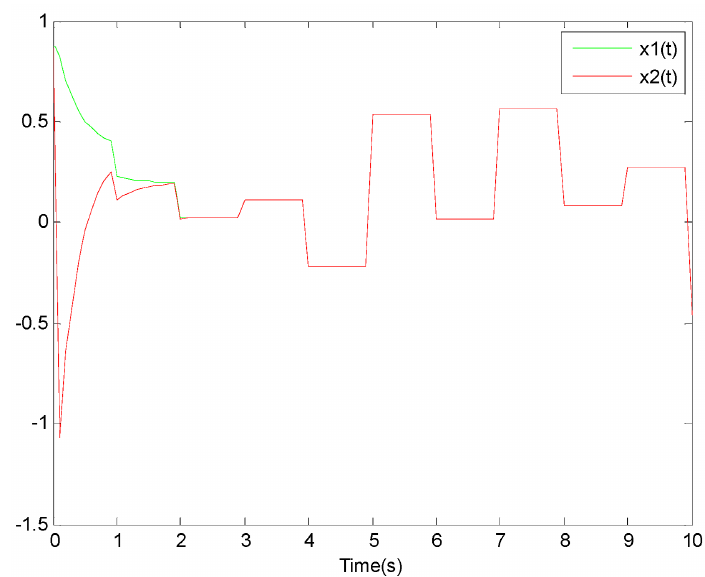
Figure 19. The state evolutions x 1 ( t ) , x 2 ( t ) with σ =